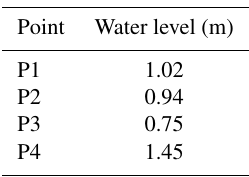
for R 2 T 2 C 2 and R 2 T 2 C 3 . The runoff is more intense for R 2 T 2 C 2 and R 2 T 2 C 3 than for R 2 T 1 C 1 and R 2 T 2 C 1 , espe-